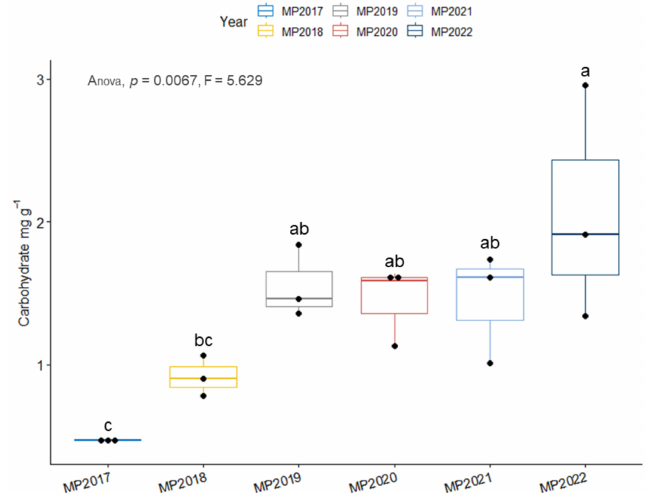
Figure 2. The M. polymorpha seeds’ carbohydrate contents. In M. polymorpha seeds, carbohydrates decreased by 22.7% of new seeds (from 2022) in the 6th year of storage, and there was a plateau in carbohydrate metabolism from the 2nd to the 4th year of storage, demonstrating an extraordinarily significant link between carbohydrates and storage years. The results of the analysis of the significance of differences between multiple samples, based on Duncan’s multiple range test, are represented by the lowercase letters a through c, with a denoting the most significant difference and c denoting the least significant difference, at a significance level of 0.05.